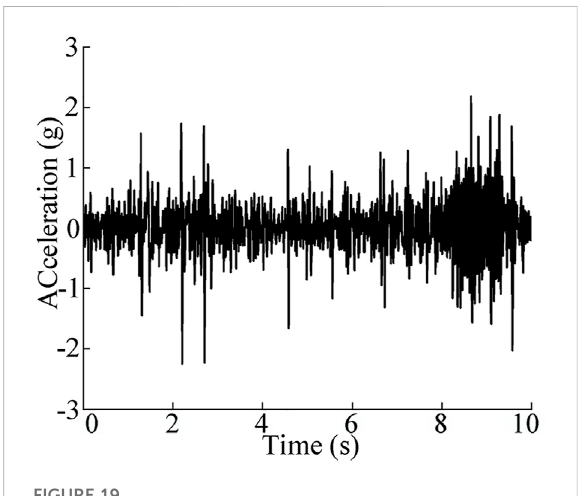
FIGURE 19 Downhole measured data.